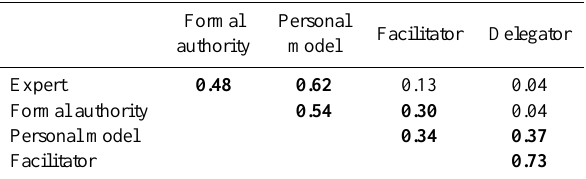
Table A2. Correlations among teaching styles for the total sample of Survey 1 (58 samples, significant (5% ∗ ) correlations > 0.26).